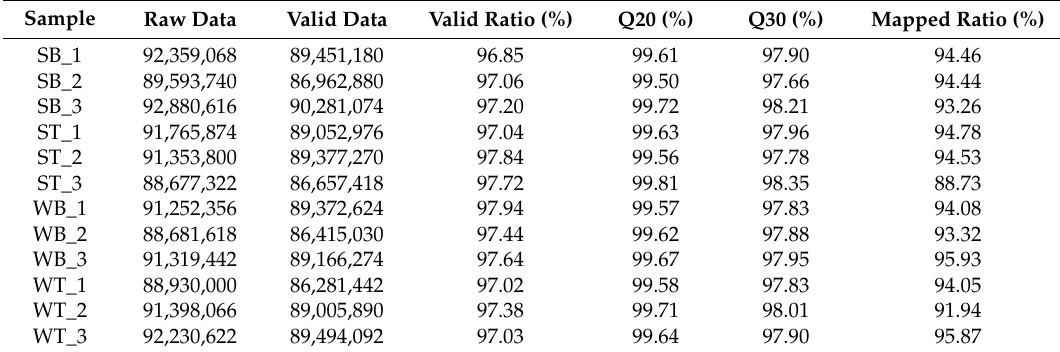
Table 1. Quality statistics of di ff erent sample sequencing